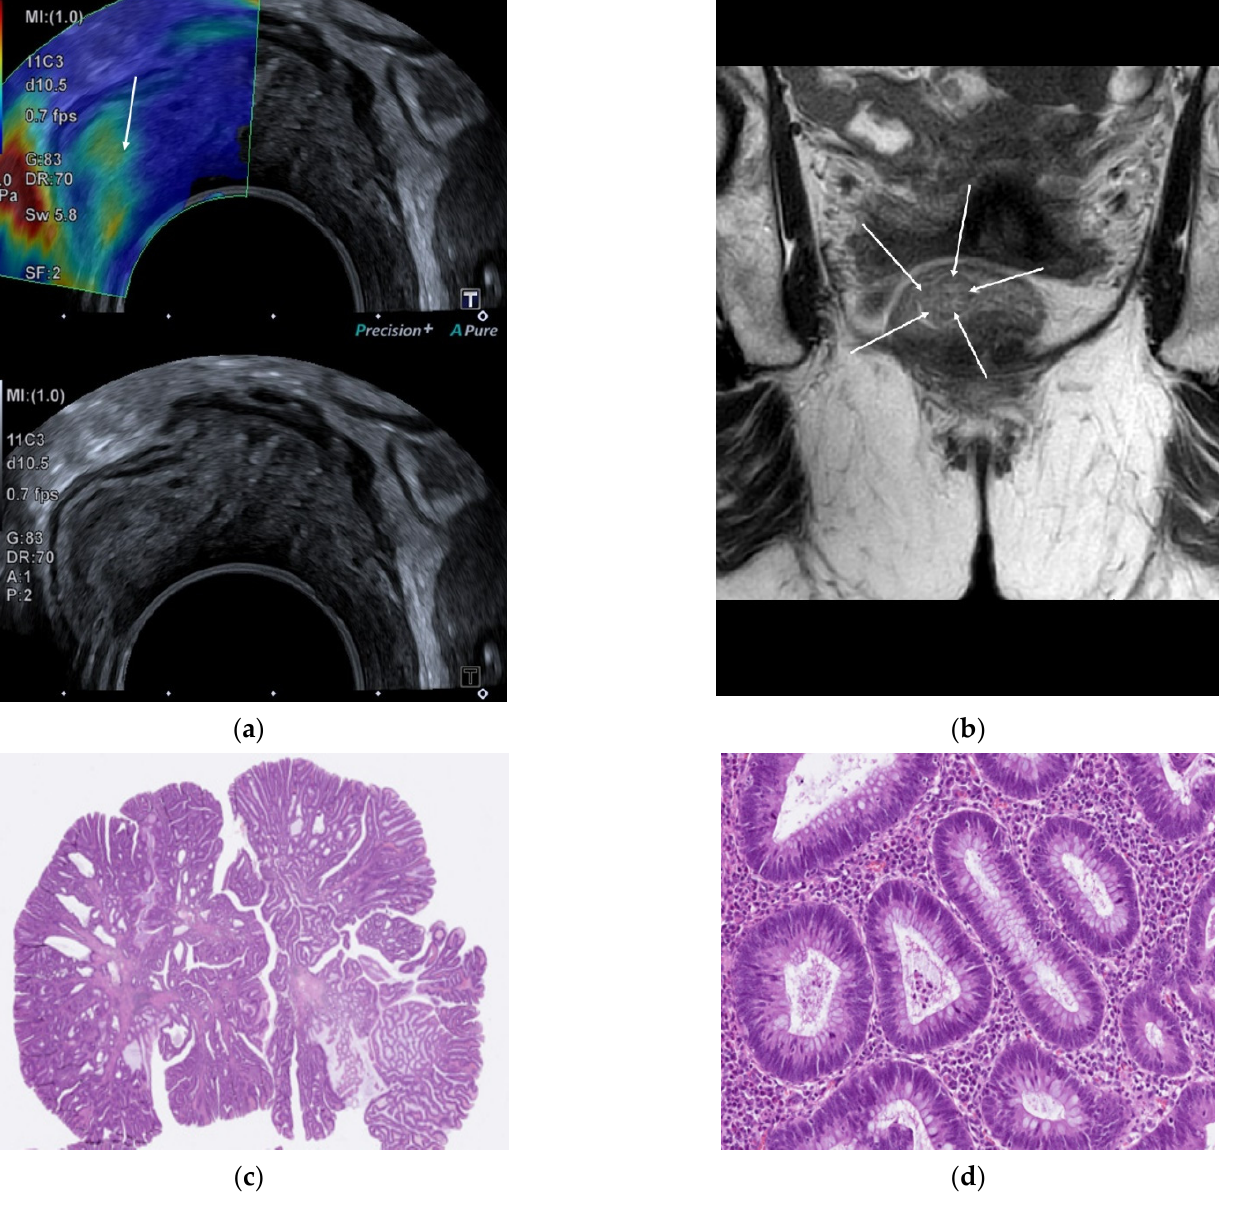
Figure 3. An 81-year-old female. ( a ) Endorectal ultrasound with shear-wave elastography color map superimposed on a B-mode image on the upper image and the corresponding B-mode on the lower image. The lesion is primarily blue and green, indicating a soft tumor. ( b ) Magnetic resonance T2-weighted image of the lesion. The white arrows indicate the lesion boundaries. ( c ) Histopathology revealing an adenoma. ( d ) 200× magnification shows an SF of <10%.